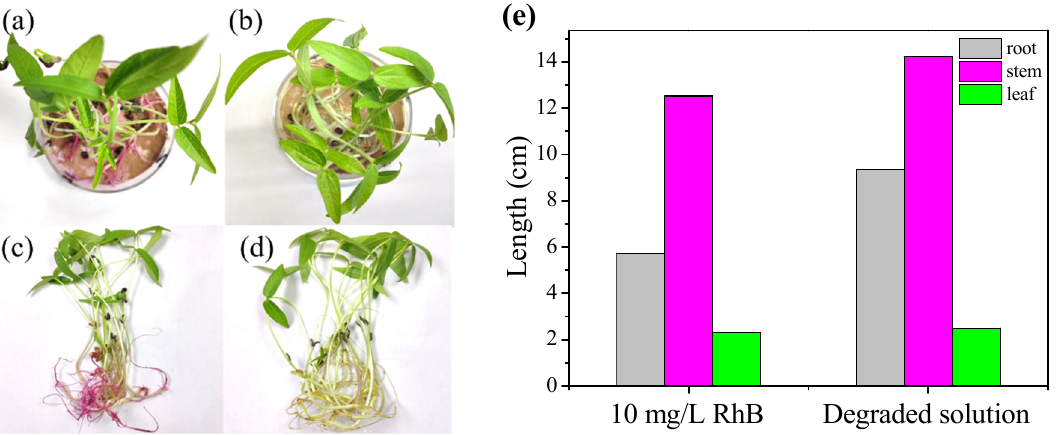
Figure 6. Ecotoxicity tests with 10 mg/L of RhB solution ( a , c ) and the degraded solution ( b , d ). ( e ) Lengths of the roots, stems, and leaves of mature mung beans in the initial and degraded solution after 9 days.